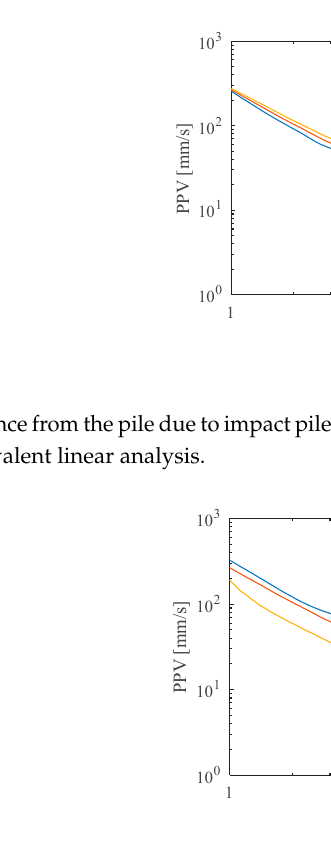
( b ) Figure 9. Vertical peak particle velocity record, in the frequency domain, for observation points at different distances from the source: ( a ) linear; ( b ) equivalent linear (upper: Vs = 80 m/s—Case 1; bottom: Vs = 160 m/s—Case 3). Considering the three values of soil stiffness previously defined, Figure 10 presents the evolution of the peak particle velocity according to the distance from the pile. As ob- served, higher vibration levels are associated with stiffer soils. There is only one exception